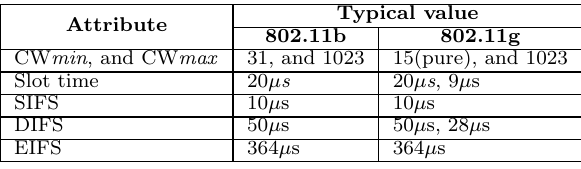
Table 1: Attribute values of 802.11b/g